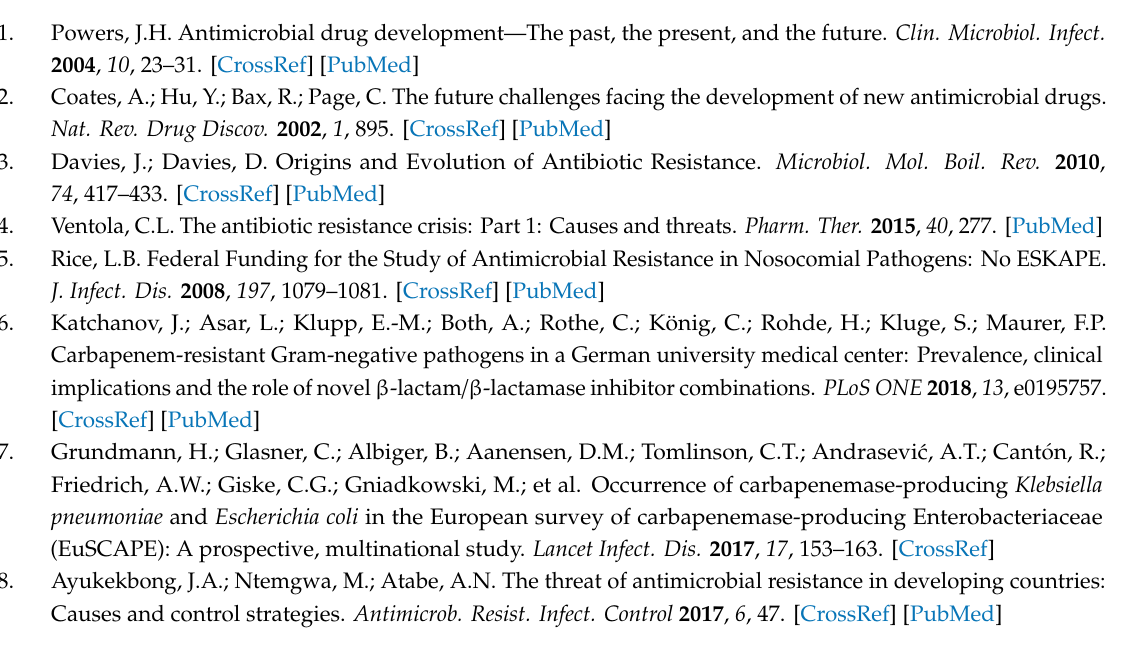
Figure S1: Possible additive e ff ect of colistin and light on the proliferation rate of E. coli DH5 α and S. Typhimurium; Figure S2: Growth kinetic of E. coli DH5 α in the presence of chlorophyllin / colistin concentrations; Figure S3: Chlorophyllin uptake into E. coli , S. Typhimurium and E. coli pGDP2: mcr-1 in the presence of colistin; Table S1: E ff ects of di ff erent colistin concentrations on the growth of E. coli DH5 α